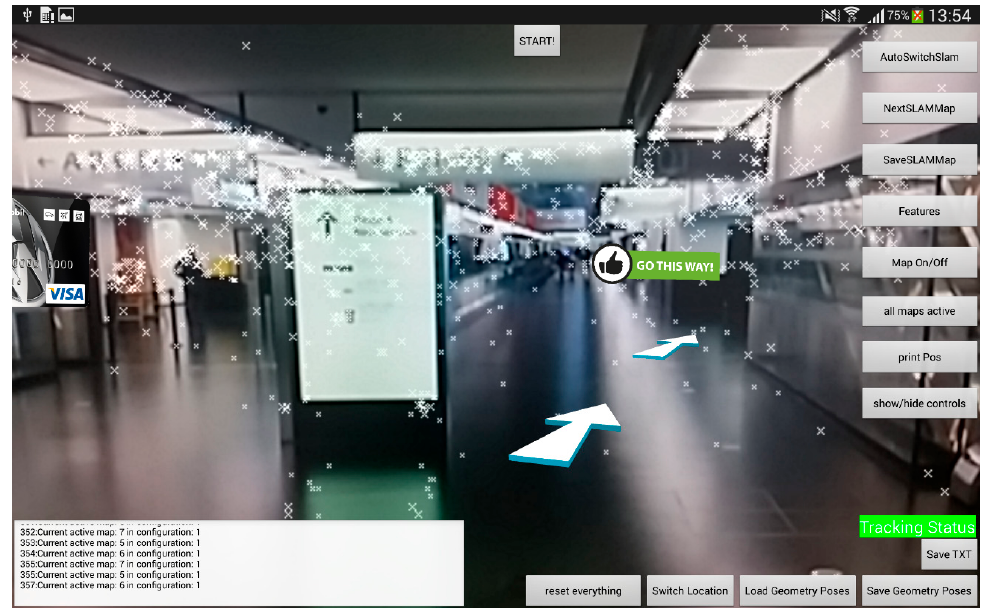
Figure 10. Tracking application including point features and path visualization.